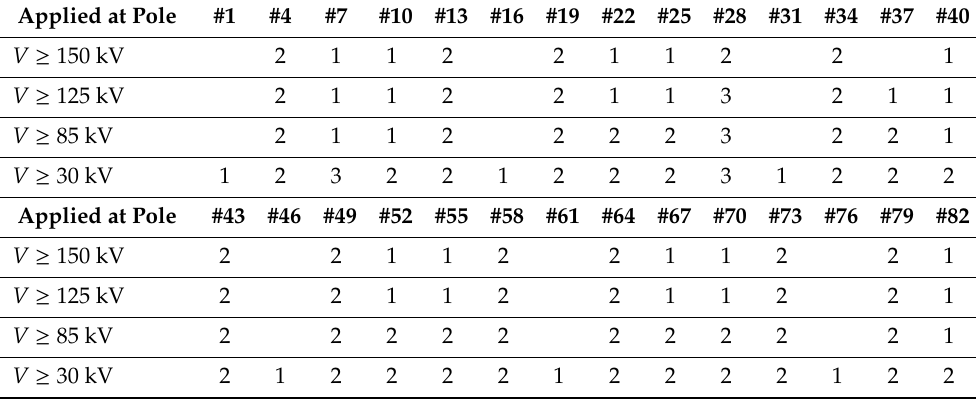
Table 2. Number of transformers with at least one phase reaching the critical overvoltage level. Case 1, wet creosote-impregnated poles and grounded transformer poles.